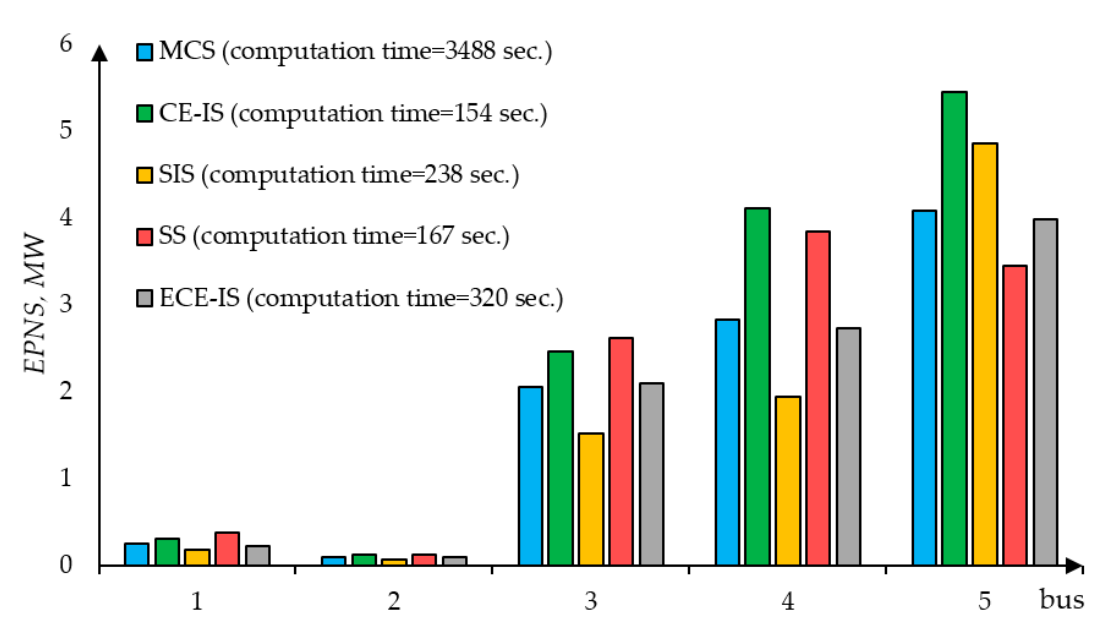
Figure 6. Test scheme buses—expected power not supplied (EPNS).